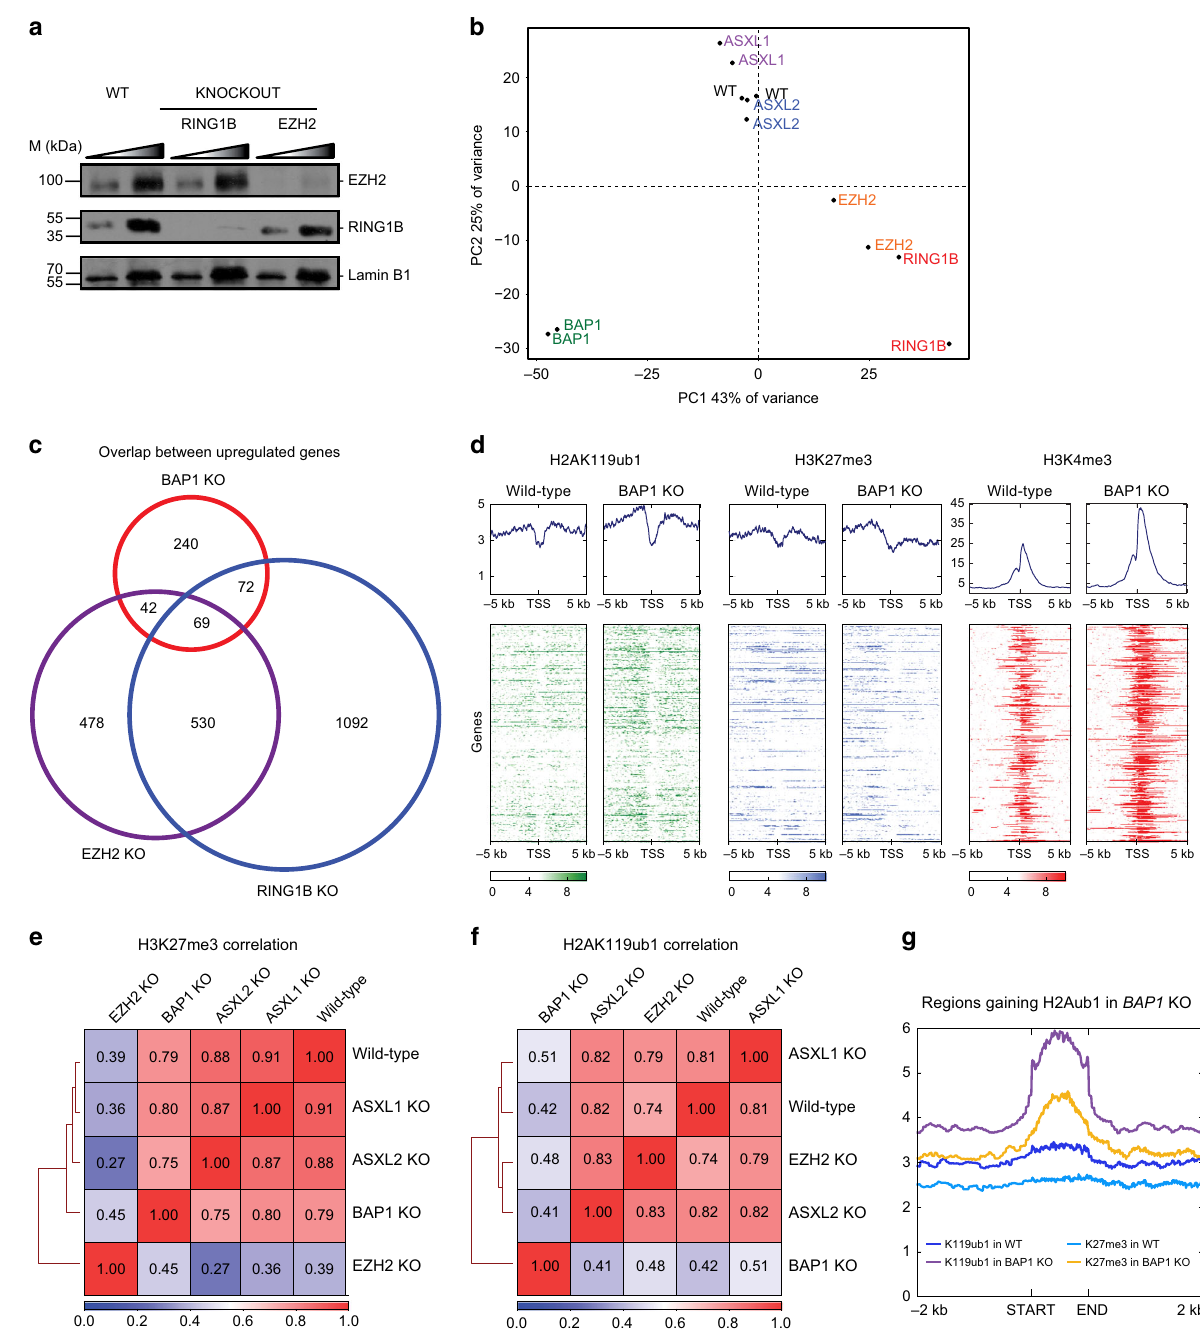
Fig. 3 BAP1.com is dispensable for Polycomb-mediated silencing. a Western blot analysis of EZH2 and RING1B in wild-type (WT), RING1B KO, and EZH2 KO cells. Lamin B1 is used as a loading control. A two-point titration (1:2 ratio) is shown for each condition. b PCA analysis of WT, RING1B , EZH2 , ASXL1 , ASXL2 , and BAP1 KO transcriptome. c Venn diagram showing the overlap between genes upregulated in BAP1 , EZH2 , or RING1B KO cells. d Heatmaps showing H2AK119ub1, H3K27me3, and H3K4me3 distribution in a − 5/ + 5 kb window around the transcription start site (TSS) of genes upregulated in BAP1 KO cells in wild-type and BAP1 KO cells. Corresponding average pro fi les are plotted on top of each heatmap. e , f Correlation heatmap of H3K27me3 ( e ) and H2AK119ub1 ( f ) distribution between wild-type cells and the different KO conditions indicated. g Plots showing average enrichment of H2AK119ub1 and H3K27me3 in wild-type and BAP1 KO cells at regions that gain H2AK119ub1 upon BAP1